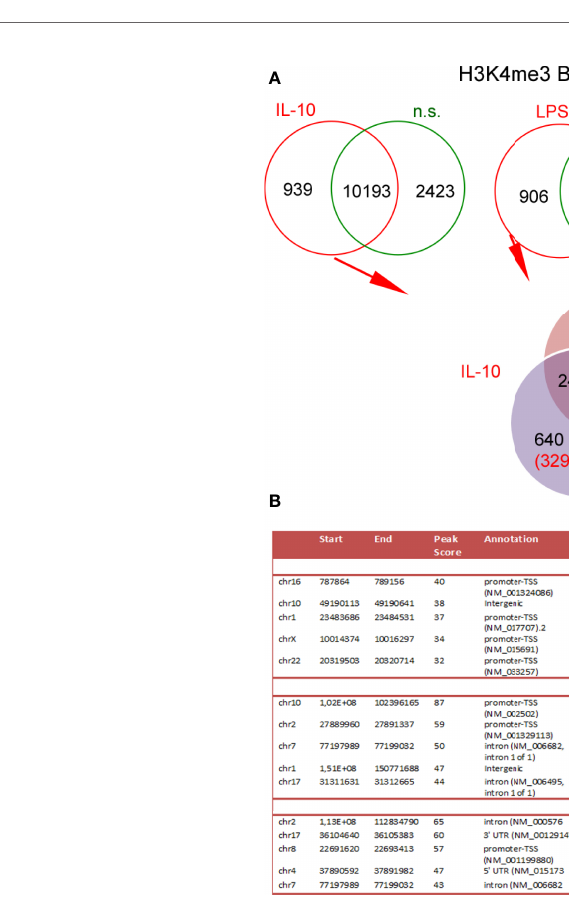
FIGURE 4 | Binding site overlaps within H3K4me3-marked histone pointed DNA associated region with speci fi c activation by IL-10, TNF- a , or LPS stimulation. (A) Pie chart of H3K4me3 binding site distribution in comparison to different stimuli. The number of statistically signi fi cant DNA binding sites with the low FDR is given in brackets. Pie charts were performed on the mean values obtained from four independent experiments. (B) Detailed characterization of IL-10, TNF- a , and LPS speci fi c binding sites with the fi ve highest statistical signi fi cances and the lowest FDR; n.s,